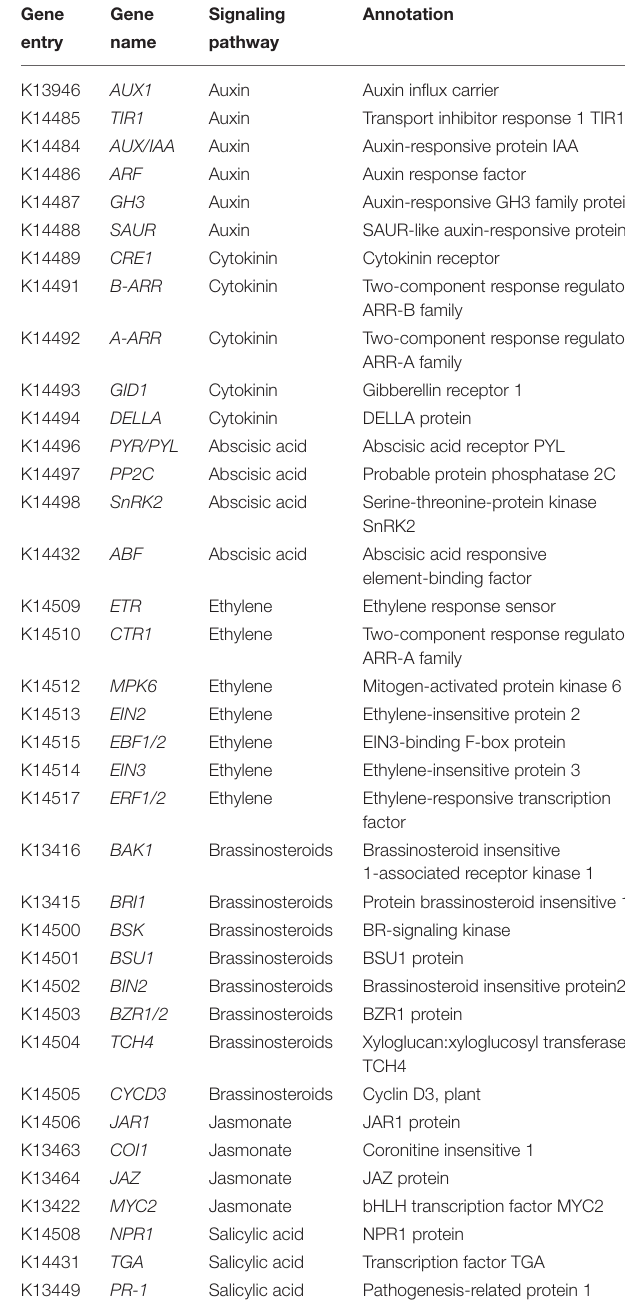
pathway in radish. Gene Gene